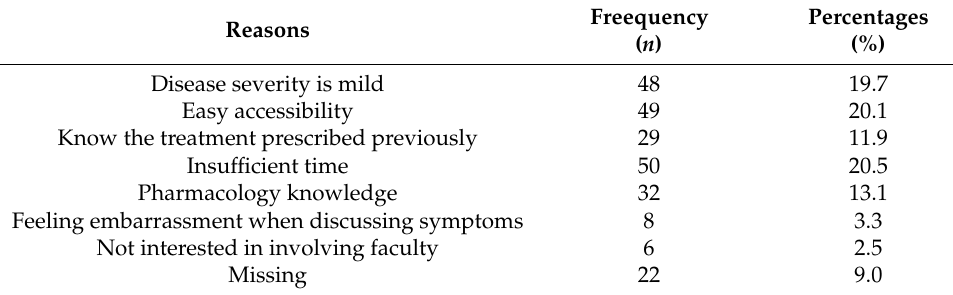
Table 5. Reason for self-medication ( n = 244).